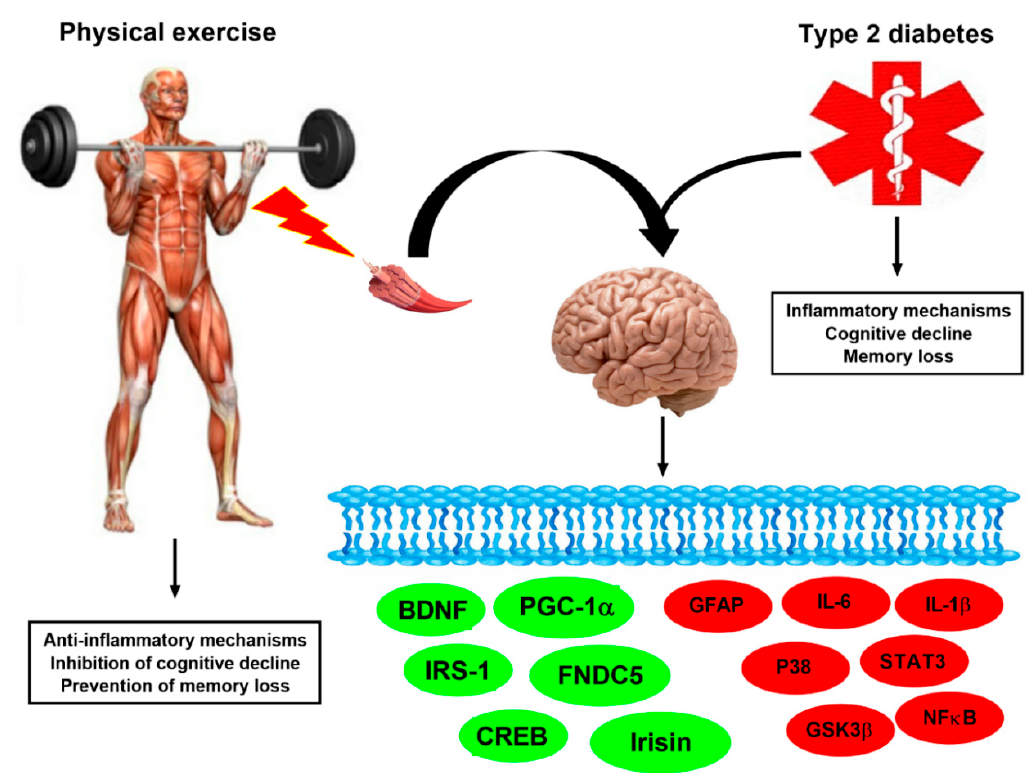
Figure 4. Exercise-linked irisin: potential molecular mechanisms on cognitive function and memory in T2DM. Proteins that are upregulated due to exercise in green (PGC-1 α , FNDC5, irisin, BDNF, CREB, and IRS-1); proteins downregulated or that maintain their levels unaltered are in red (GFAP, IL-1 β , IL-6, P38, STAT3, NF κ B, and GSK β ) in T2DM. Thus, anti-inflammatory mechanisms occur due to exercise in T2DM. These potential exercise effects are suggested to protect against cognitive decline and memory loss in T2DM.